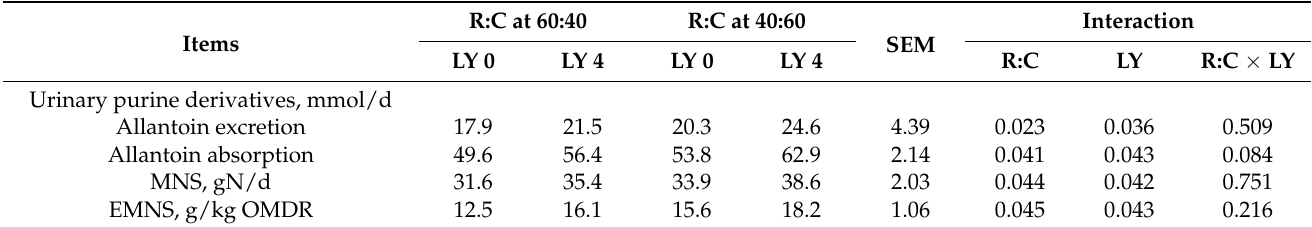
Table 5. Effect of concentrate level and live yeast supplementation on urinary purine derivatives (PD) and microbial protein synthesis in Thai native beef